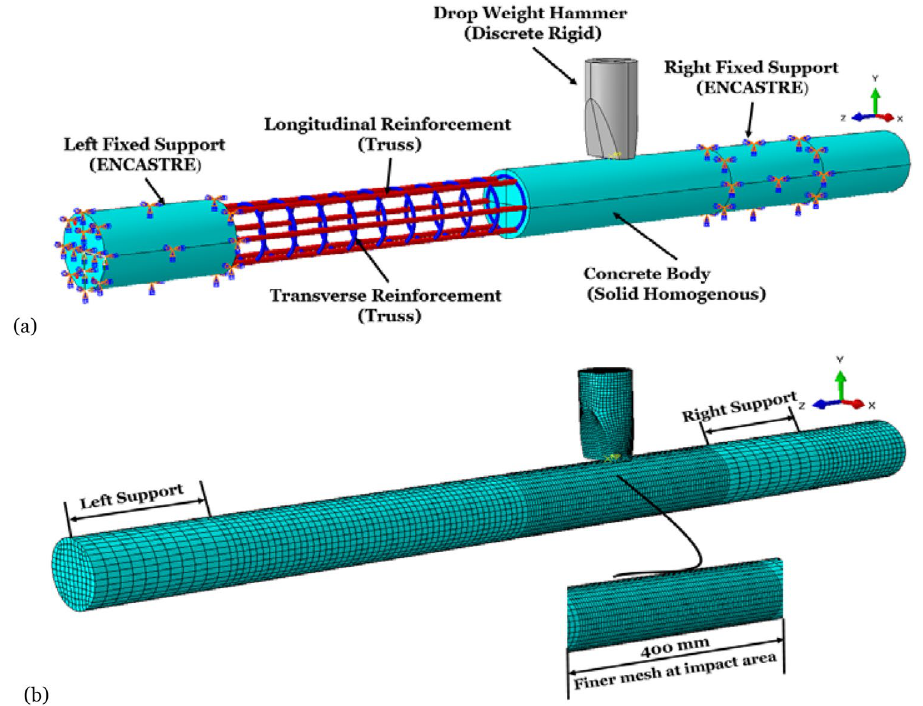
Figure 3. ( a ) FEM modeling assembly; ( b ) FEM meshing.